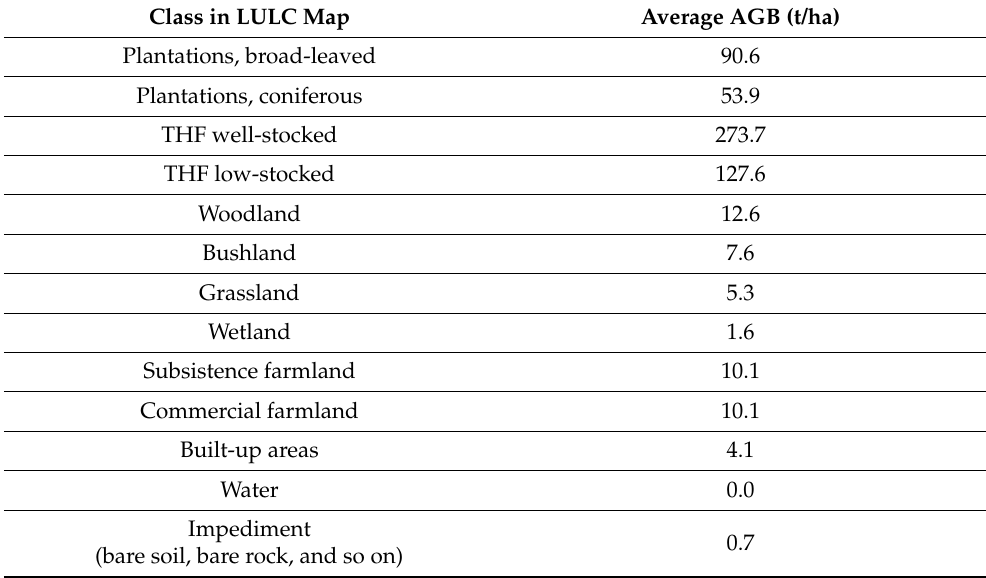
Table 3. LULC classes and AGB stock data used in the AoIs in western and southwestern Uganda.